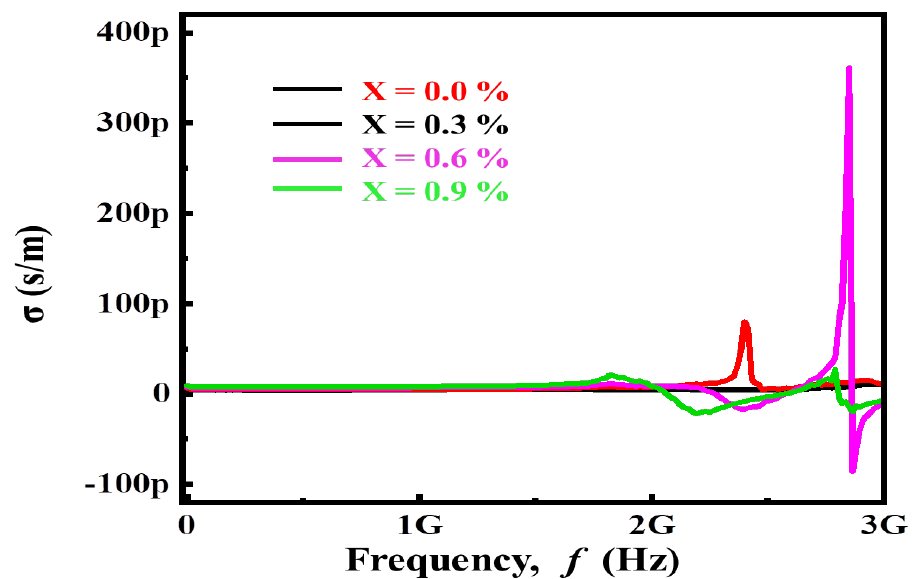
Figure 4. Variation of conductivity as a function frequency for (Ba 1−x Ca x )Ti 4 O 9 (x = 0.0, 0.3, 0.6 and 0.9) sintered ceramics.